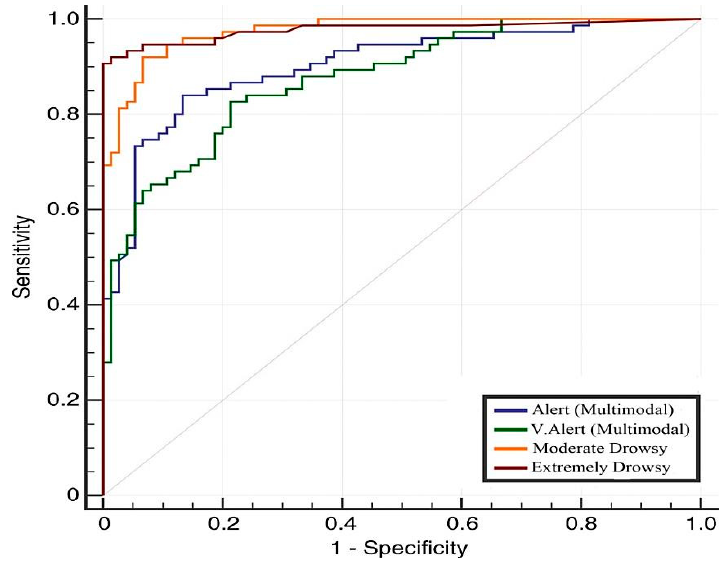
Figure 8. A graph to shows state-of-the-art system comparisons area under the receiver operating curve (AUC) for four class-based (alert, very alert, moderate drowsy, and extremely drowsy) DFD systems.